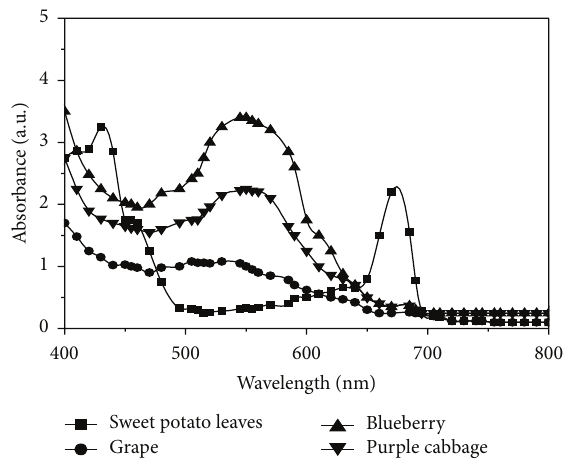
Figure 3: The absorption spectra for extracts of sweet potato leaf, grape, blueberry, and purple cabbage, in ethanol solution.